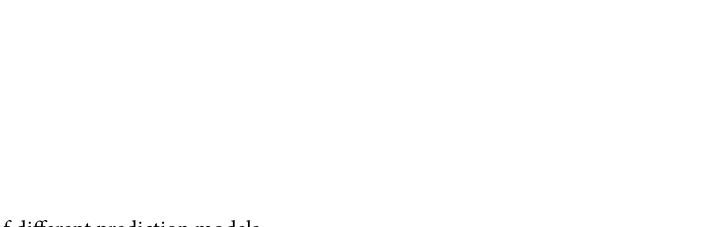
Table 5. The AUCs and AUPRs of different prediction models.